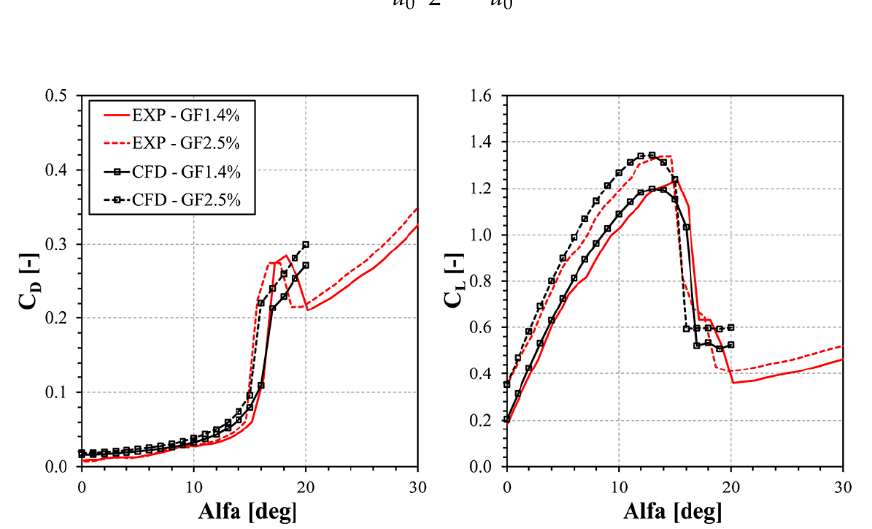
Figure 10. Comparison experimental results and CFD computations for static flow around airfoil equipped with GF at different values of angle of attack.